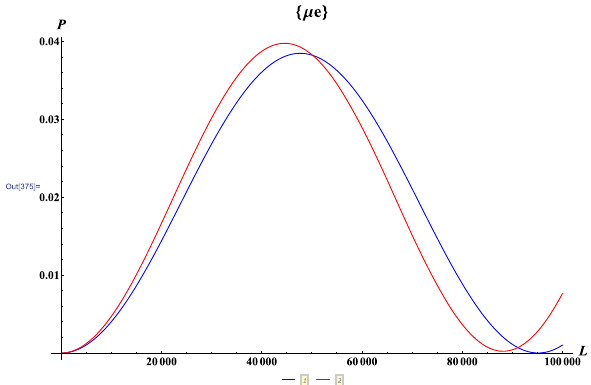
Fig. 4 SameanalysisofFig.1,butforLIVparameters δ f kj oftheorder of 10 − 25